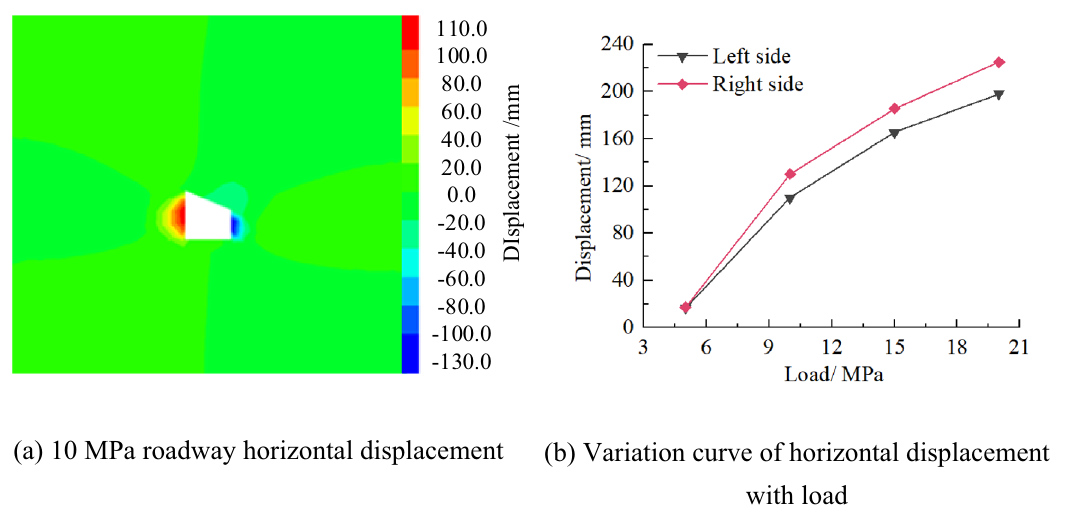
Figure 20. Distribution law of roadway horizontal